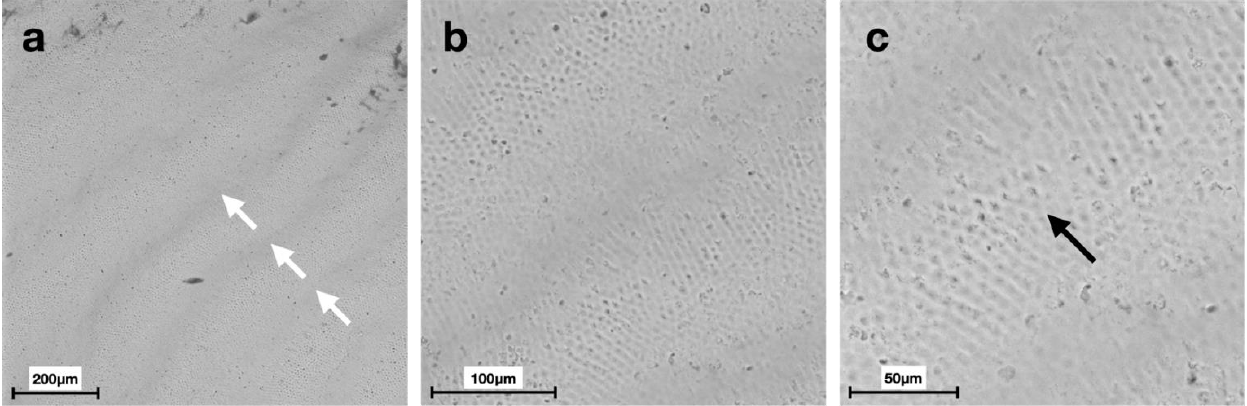
Figure 2. Scanning electron micrographs of G6 (group without any treatment): ( a ) the presence of perikymatas on the enamel surface (white arrows) at 200× magnification; ( b , c ) the crystalline structure composed of enamel prisms and the intact interprismatic area (black arrow) at 500× and 1000× magnification, respectively.